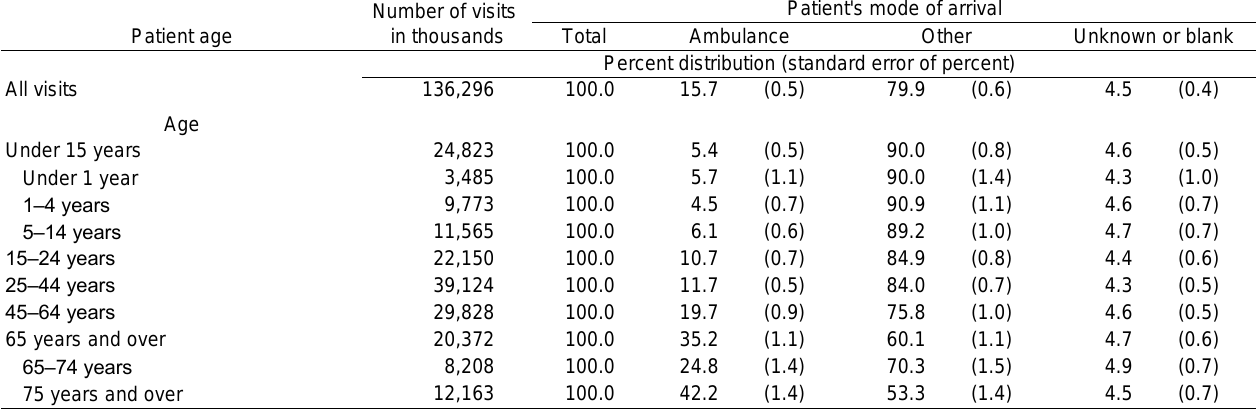
Table 5. Mode of arrival at emergency department, by patient age: United States,